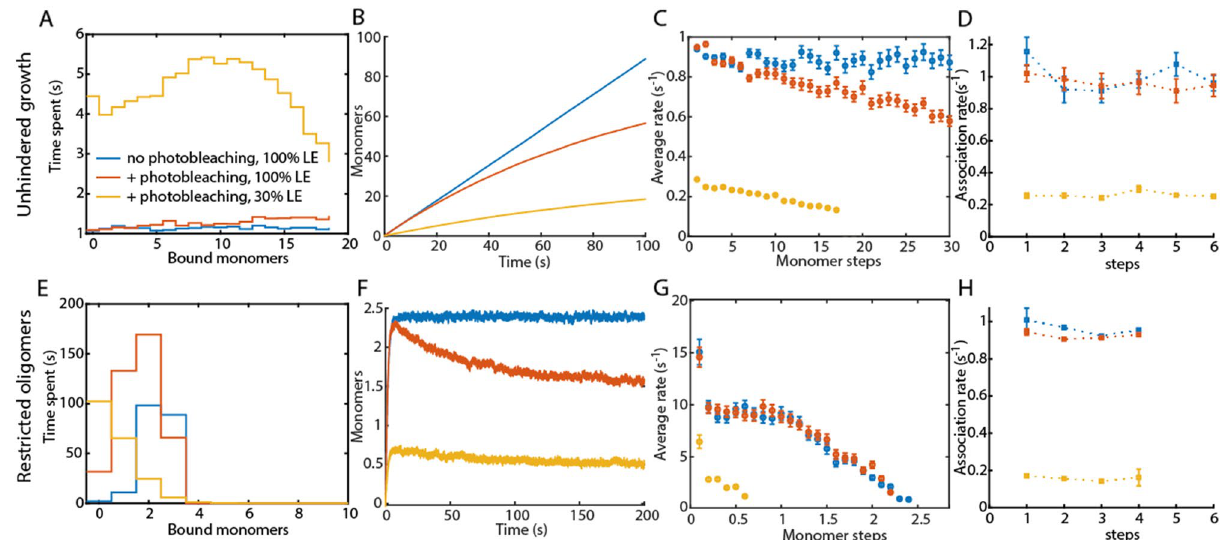
Figure 3. Effect of photobleaching and labeling efficiency on unhindered growth and restricted growth that stops after the assembly of four monomers. Both unhindered ( A – D ) and restricted growth ( E – H ) were simulated using k + poly = 1/s and k − poly = 0.1/s. The visitation analysis ( A , E ), average rates ( C , G ) extracted from the average traces ( B , F ) and dwell-time analysis ( D , H ) were applied to data with 100% labeling efficiency and no photobleaching (blue data). The average trace of restricted growth reaches only 2.5 monomers, despite possible growth until 4 monomers, because of the equilibrium between the on- and the off-rate. The effect of a photobleaching rate of 0.01/s does not significantly influence the extracted rates and the visitation analysis (red data). The combination of stochastic labeling of 30% and photobleaching with a rate of 0.01/s affects all analysis methods (yellow). Error bars for the dwell-time analysis represent the 95% confidence intervals of the exponential